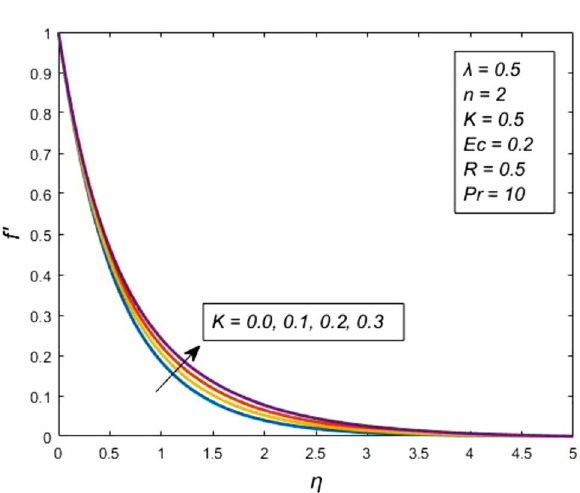
Figure 2. Impact of viscoelastic parameter K on the velocity